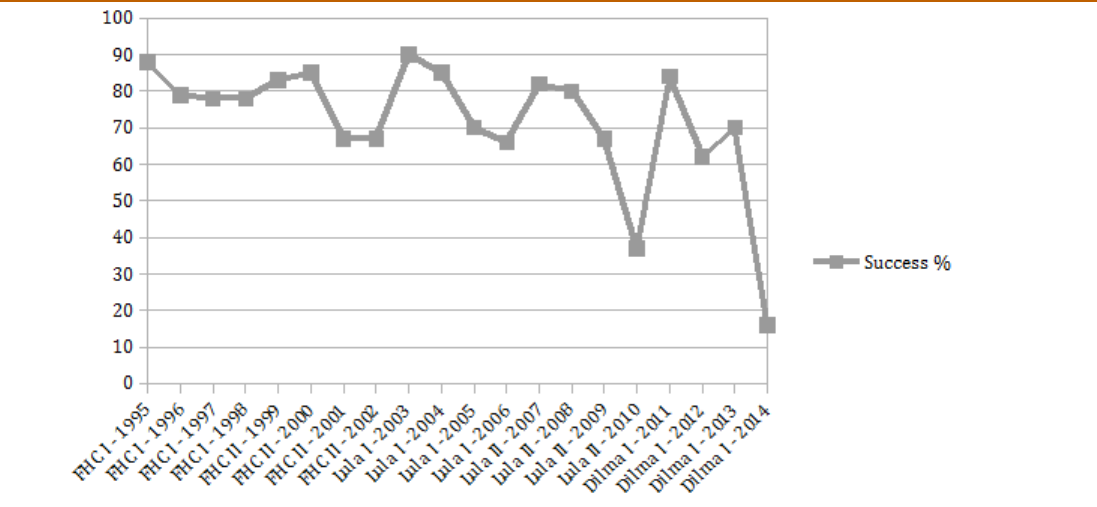
Figure 2: Annual variation in legislative success of the Executive (1995-2014)